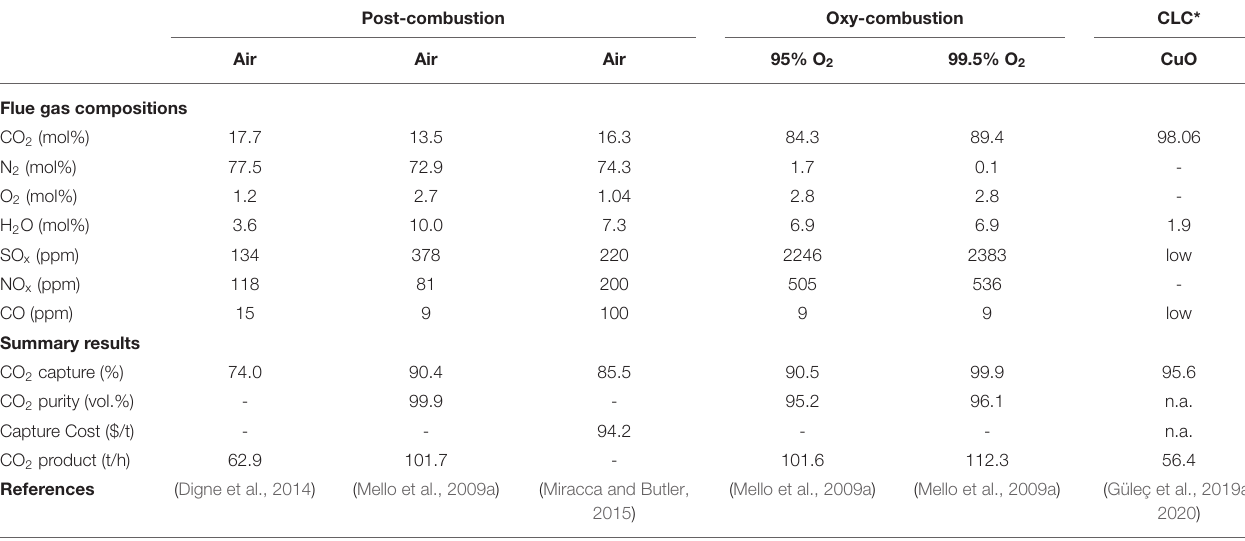
TABLE 1 | Flue gas compositions and summary